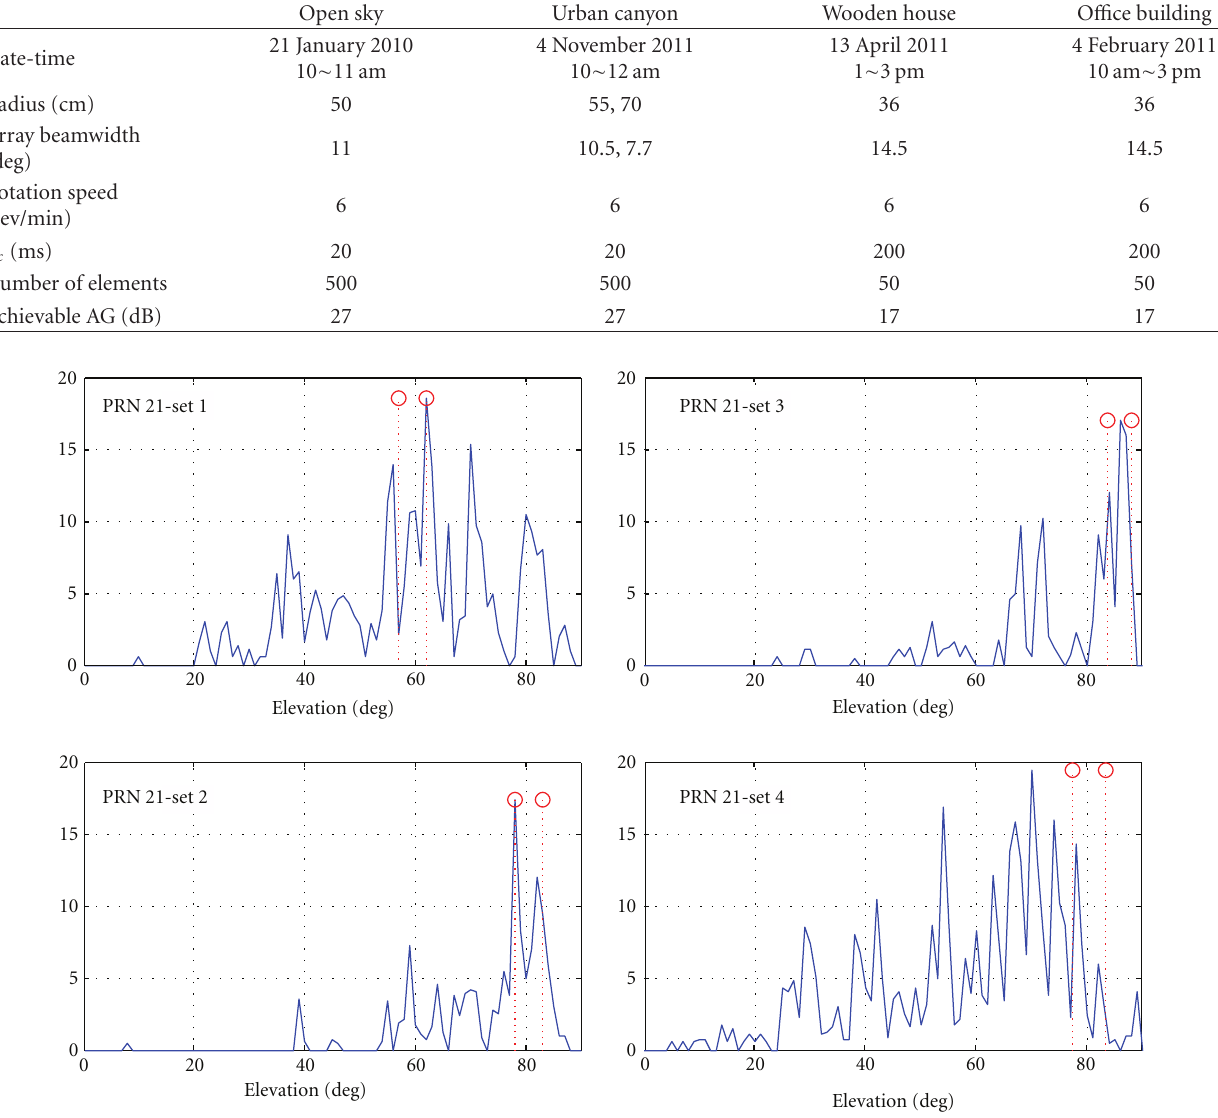
Figure 10: Measured AS for the first four sets of data in the